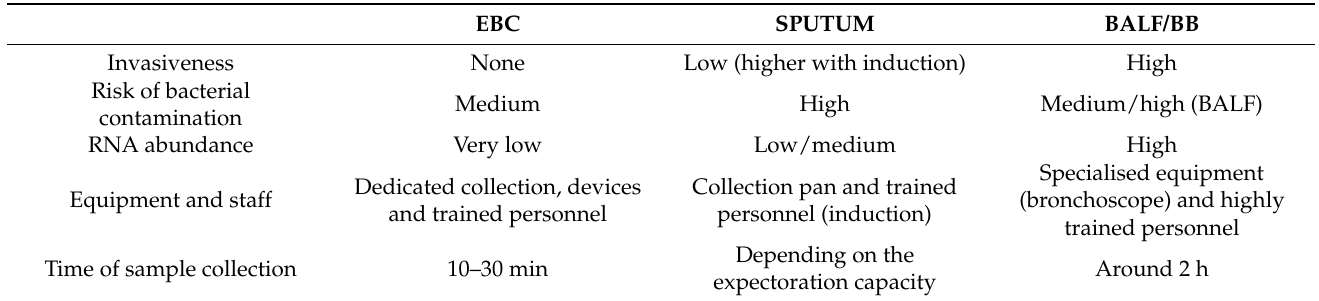
Table 4. Comparison of selected biosamples collected from the respiratory tract. Described criteria relate to collection procedure and RNA